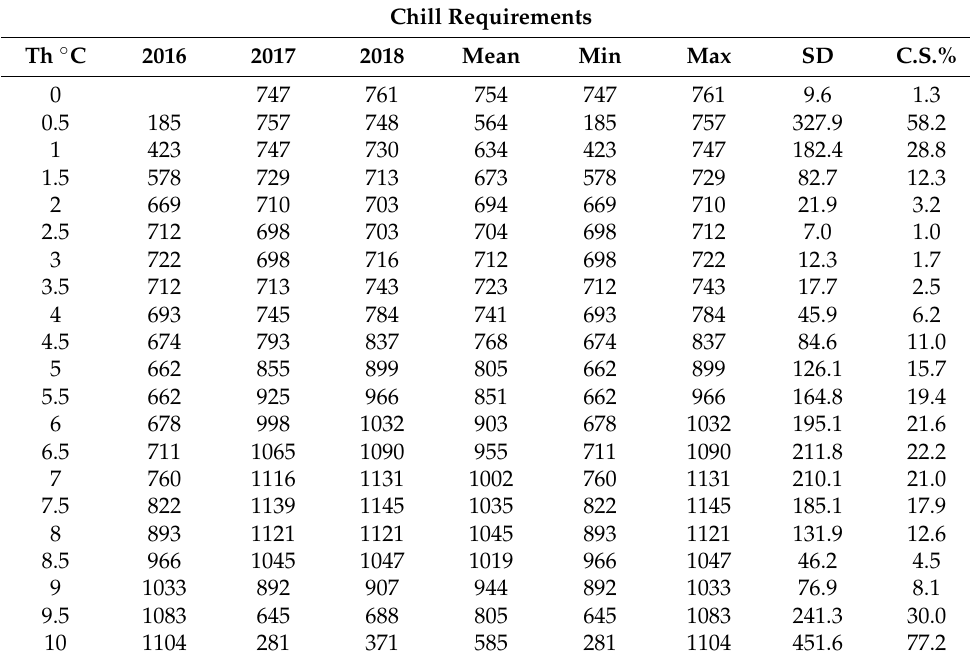
Table 1. Chilling requirements (chilling hours) obtained by means of the vegetative acticity (V.A.) method (Jato et al. [42]). Threshold temperature (Th), mean, maximum, minimum, standard deviation (SD) and coefficient of Standard deviation in percentage (C.S.%).